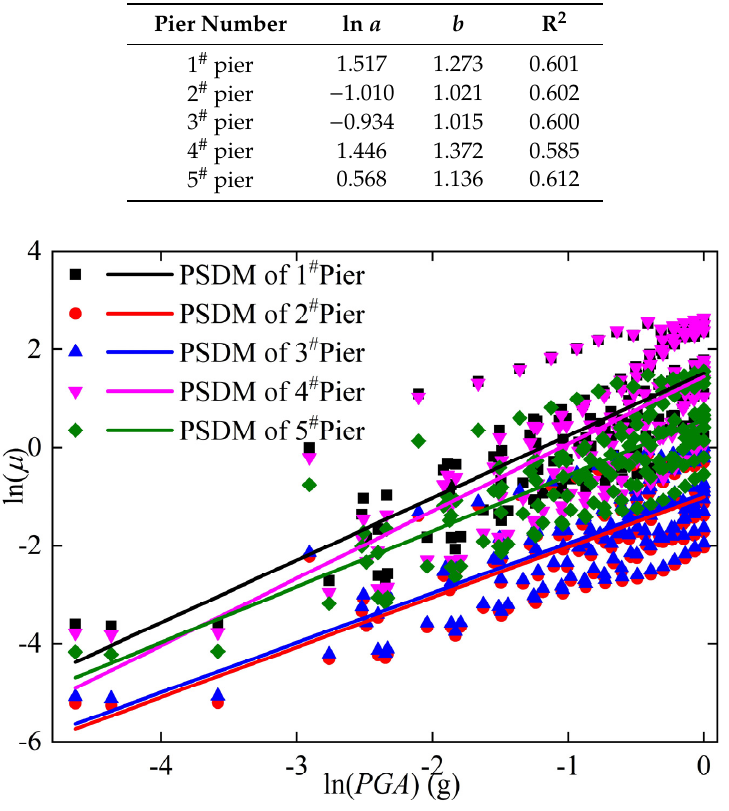
Table 3. The regression parameters and determination coe ffi cients.